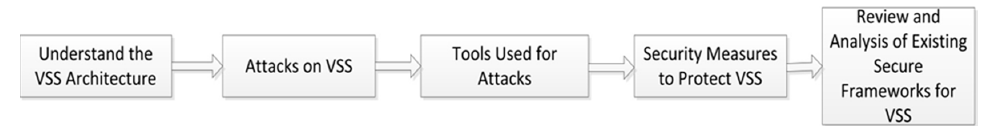
Figure 3. Roadmap of the paper.